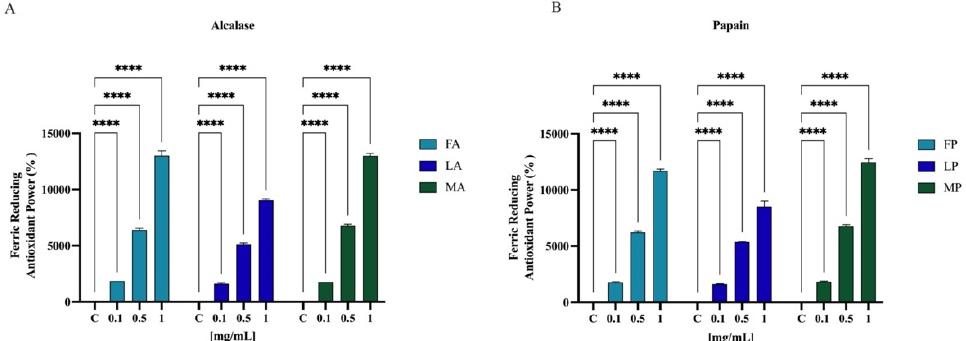
Figure 8. Antioxidant power evaluation by ferric reducing antioxidant power (FRAP) of olive seed hydrolysates from Frantoio (F), Leccino (L), and Moraiolo (M) obtained using Alcalase (A) ( A ) and Papain (P) ( B ). Data represent the mean ± s.d. of six determinations performed in triplicate. All the data sets have been analyzed by Two-way ANOVA. (****) p < 0.0001.